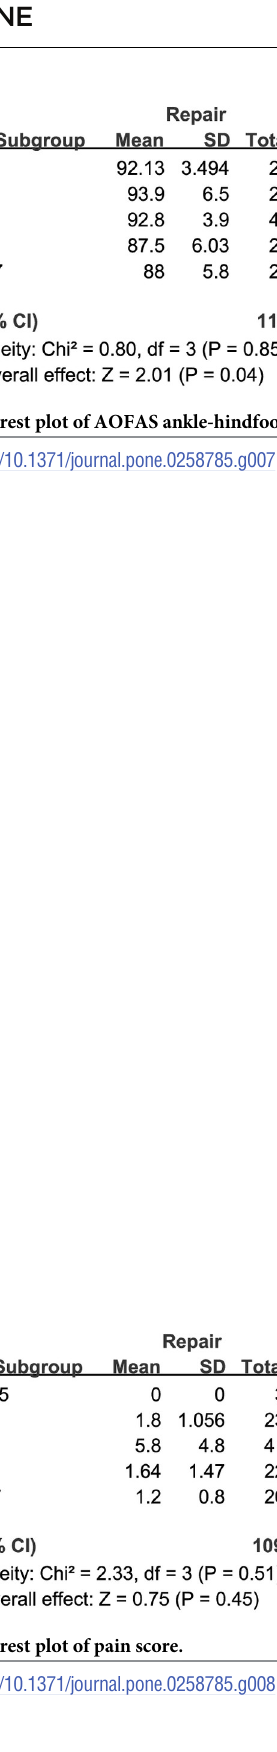
PLOS ONE | https://doi.org/10.1371/journal.pone.0258785 November12,